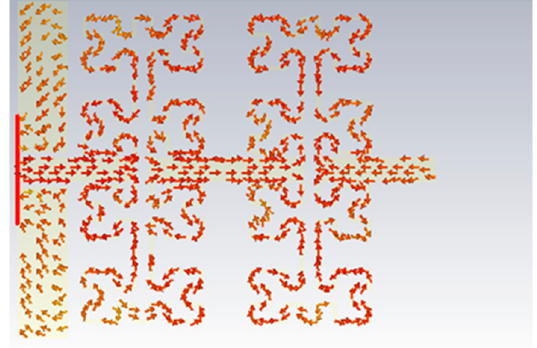
Figure 3. Current motion on the proposed Moore unit cells.